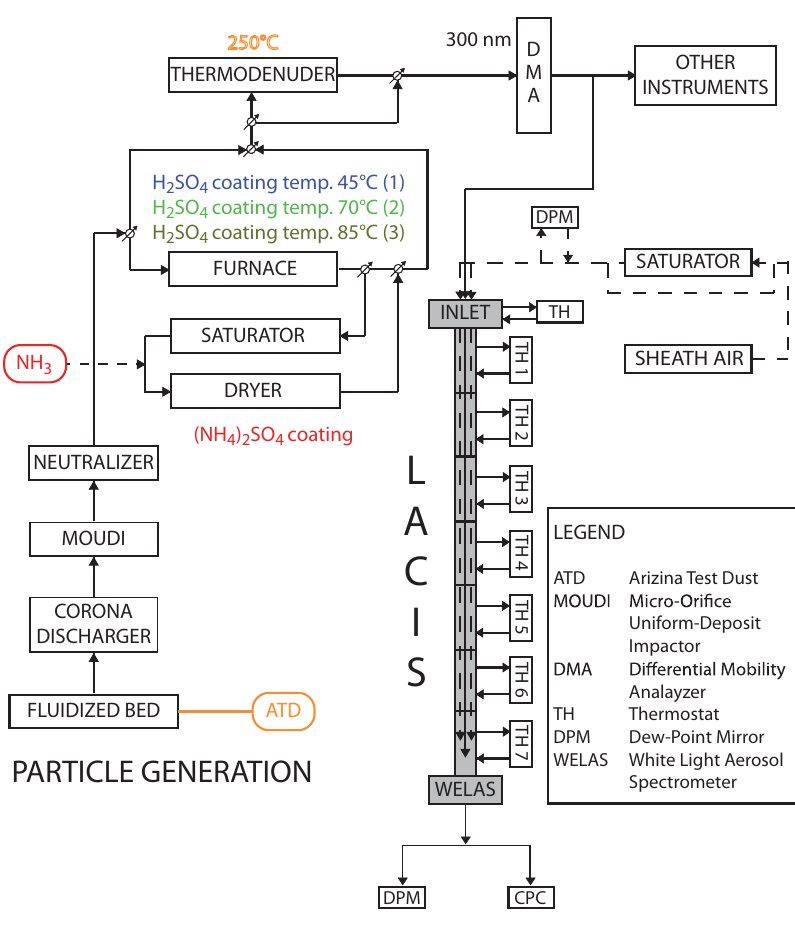
Fig. 1. Sketch of the generation, coating and size selection of the particles. Also included are the setup of particle conditioning and LACIS laminar flow tube. The “other instruments” box included CFDC, PINC, FINCH, ATOFMS, C-ToF-AMS, CCNC, H-TDMA and the